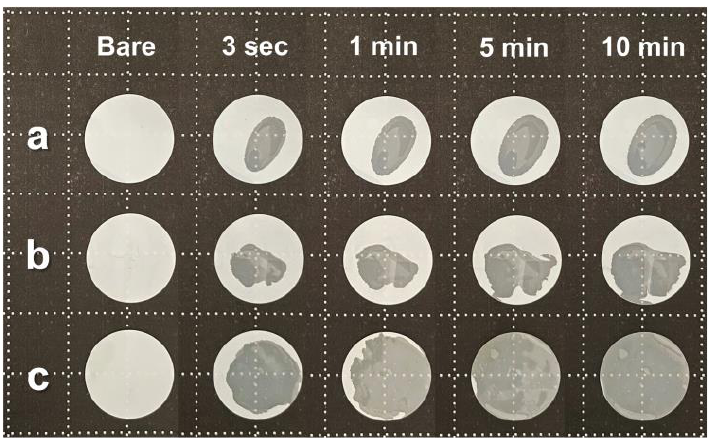
Figure 4. Digital photographs of the ( a ) PE, ( b ) TA-PE, and ( c ) PEEK@TA-PE separators after drop- ping the electrolyte.